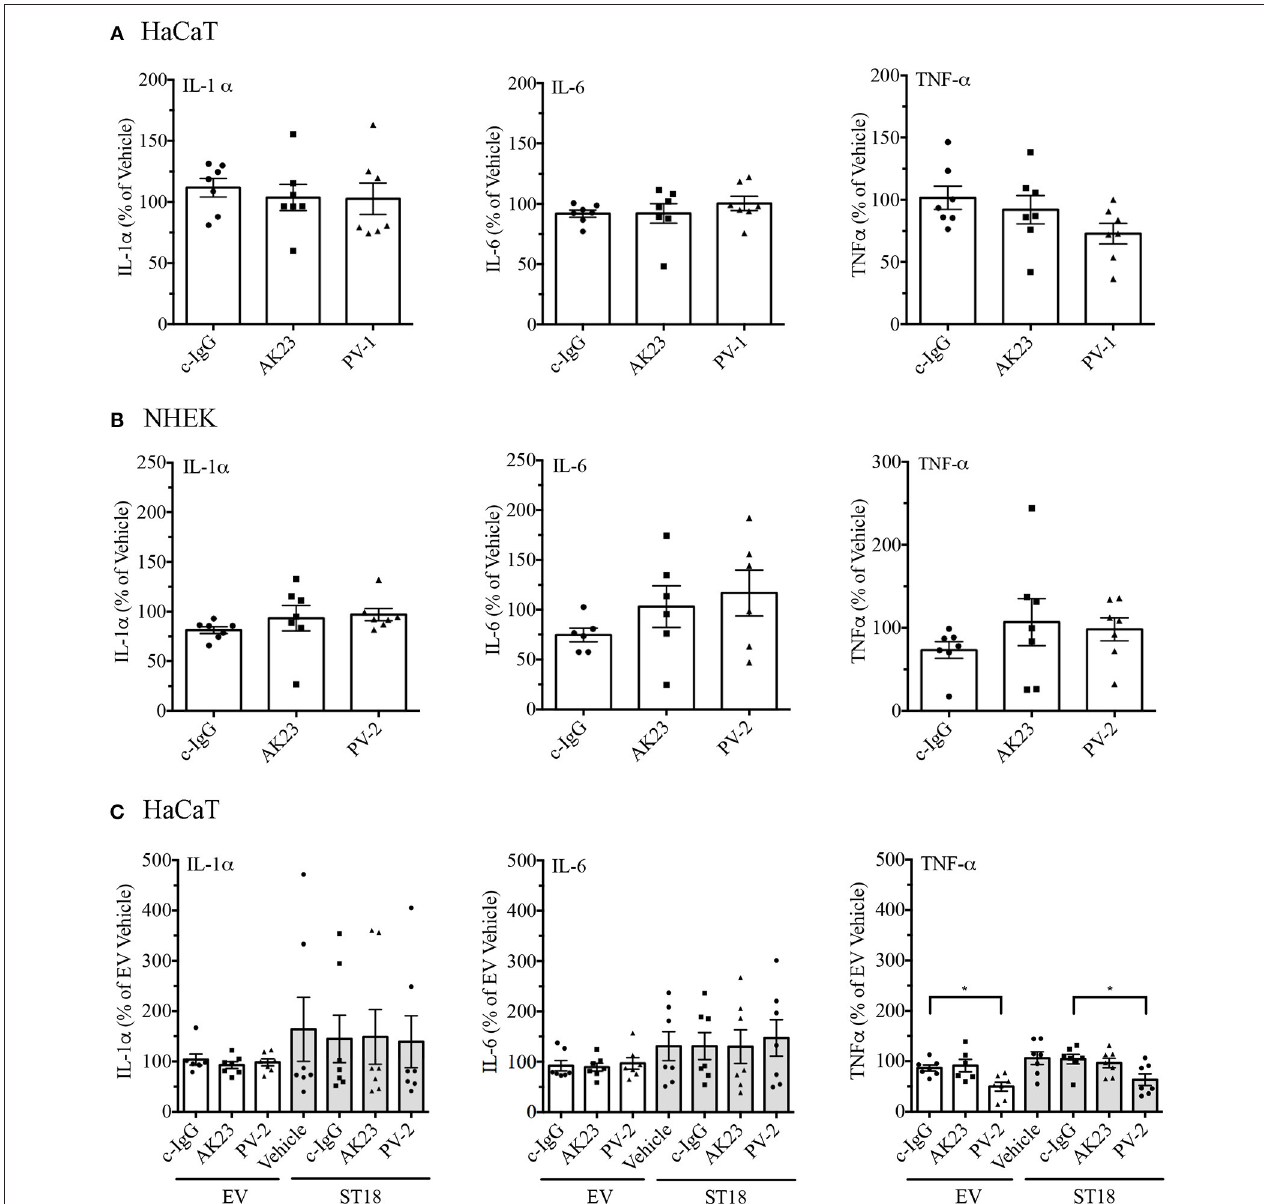
FIGURE 3 | Release of pro-inflammatory cytokines in response to pemphigus autoantibodies and ST18 overexpression. The content of cytokines in supernatants collected from cell monolayers, which were either treated with controls (Vehicle, c-IgG), AK23 or PV-IgGs, was evaluated in both HaCaT (A) and NHEK (B) cells. (C) Cytokine release by HaCaT cells transiently transfected with either EV or ST18 expression vectors and exposed to PV-IgG or AK23 was determined. All data are presented as percent of Vehicle ( n ≥ 6, two-way ANOVA; * p ≤ 0.05 vs. respective